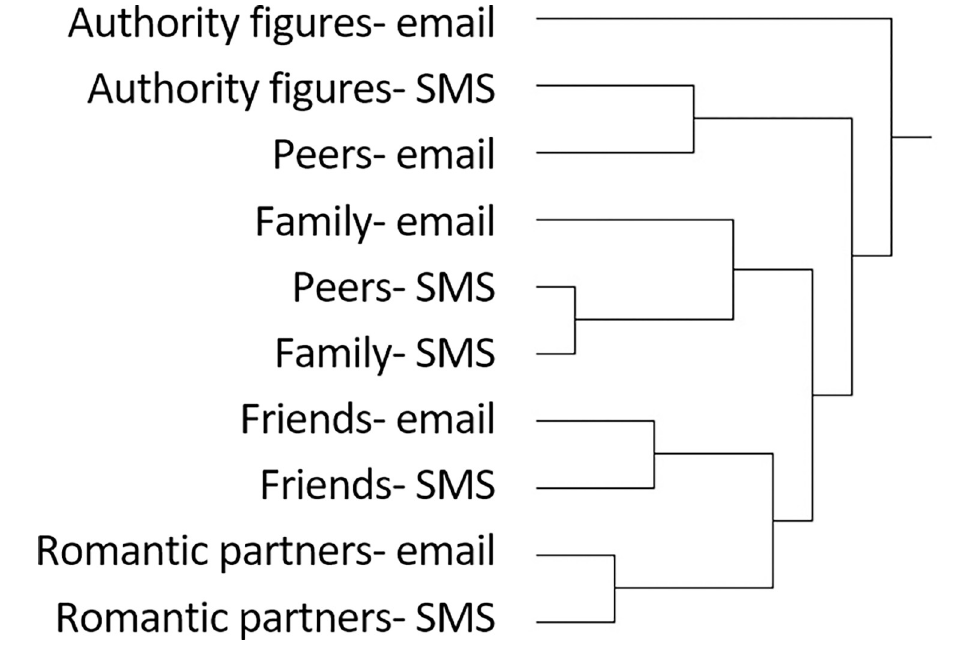
Fig 2. Results from hierarchical cluster analysis of communication types based on data in Table 5. The dissimilarity among types was measured using Euclidean distance and the clustering solution was produced using a weighted average approach. Analysis was performed using UCINET